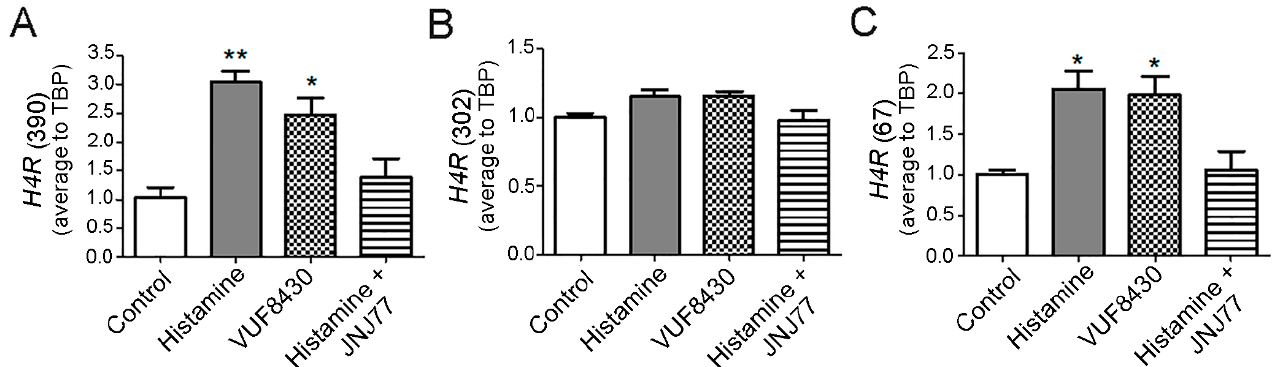
Figure 4. Regulation of H4R isoforms’ mRNA expression in HuT78 cells by histamine and H4R agonists. HuT78 cells were pre-incubated for 24 h in serum-free RPMI medium and then were left untreated (control) or were treated with histamine (10 µ M), VUF8430 (10 µ M), and histamine (10 µ M) plus JNJ77 (10 µ M) for 30 min. ( A ) Quantitative real-time RT-PCR of H4R (390) isoform mRNA levels. ( B ) Quantitative real-time RT-PCR of H4R (302) isoform mRNA levels. ( C ) Quantitative real-time RT-PCR of H4R (67) isoform mRNA levels. Measurements were performed in triplicates for each condition and cell line and data are expressed as mean ± SEM ( n = 3 independent experiments). * indicates p < 0.05, ** indicates p < 0.01 compared with Control.